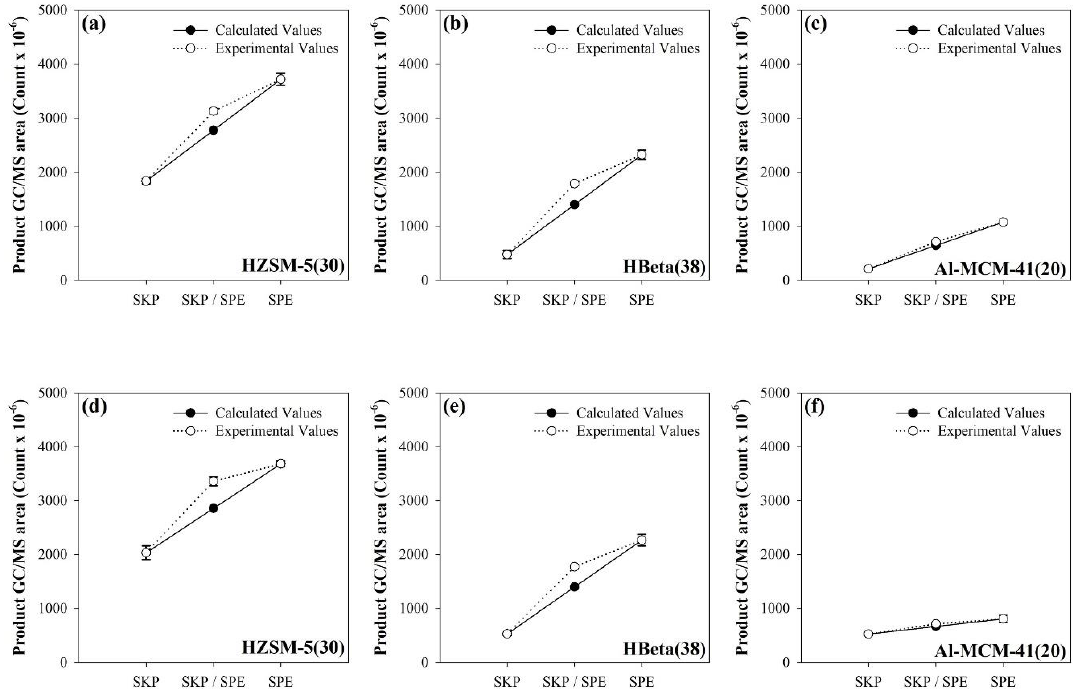
Figure 5. Experimental and calculated GC / MS areas (count × 10 -6 ) of total aromatic hydrocarbons obtained from the catalytic co-pyrolysis of SKP and SPE of TP-1 and TP-2 over HZSM-5(30), HBeta(38), and Al-MCM-41(20). TP-1 over ( a ) HZSM-5(30), ( b ) HBeta(38), and ( c ) Al-MCM-41(20); and TP-2 over ( d ) HZSM-5(30), ( e ) HBeta(38), and ( f ) Al-MCM-41(20). The calculated values were estimated by the experimental values of each product obtained from the individual catalytic pyrolysis of SKP and SPE separated from TP-1 and TP-2 according to the equation: Calculated value = (Experimental value of SKP + Experimental value of SPE)/2